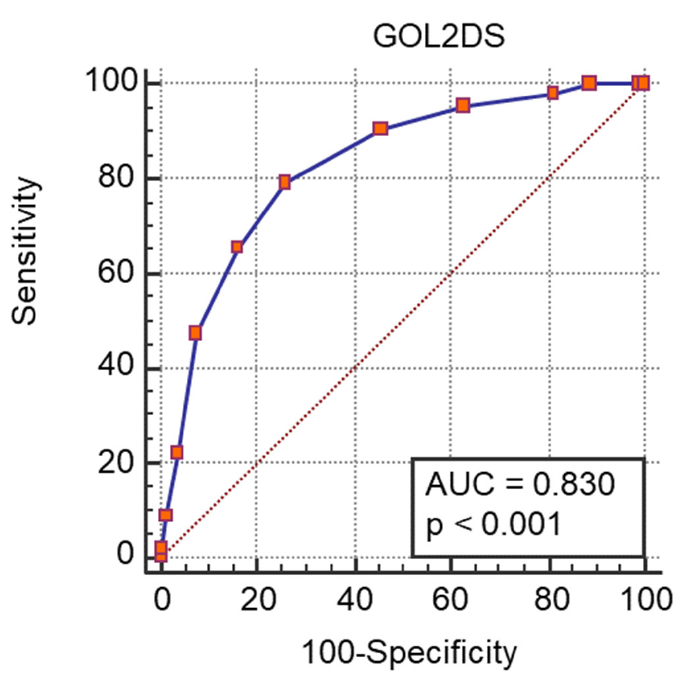
Figure 5. ROC curve and AUC values for GOL2DS score and ICU admission.